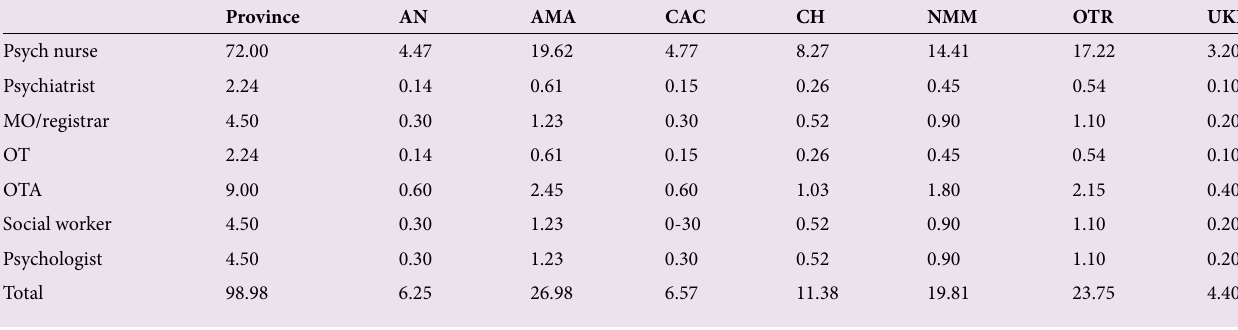
Table 9. Staff requirements for a medium-to-long-stay psychiatric service